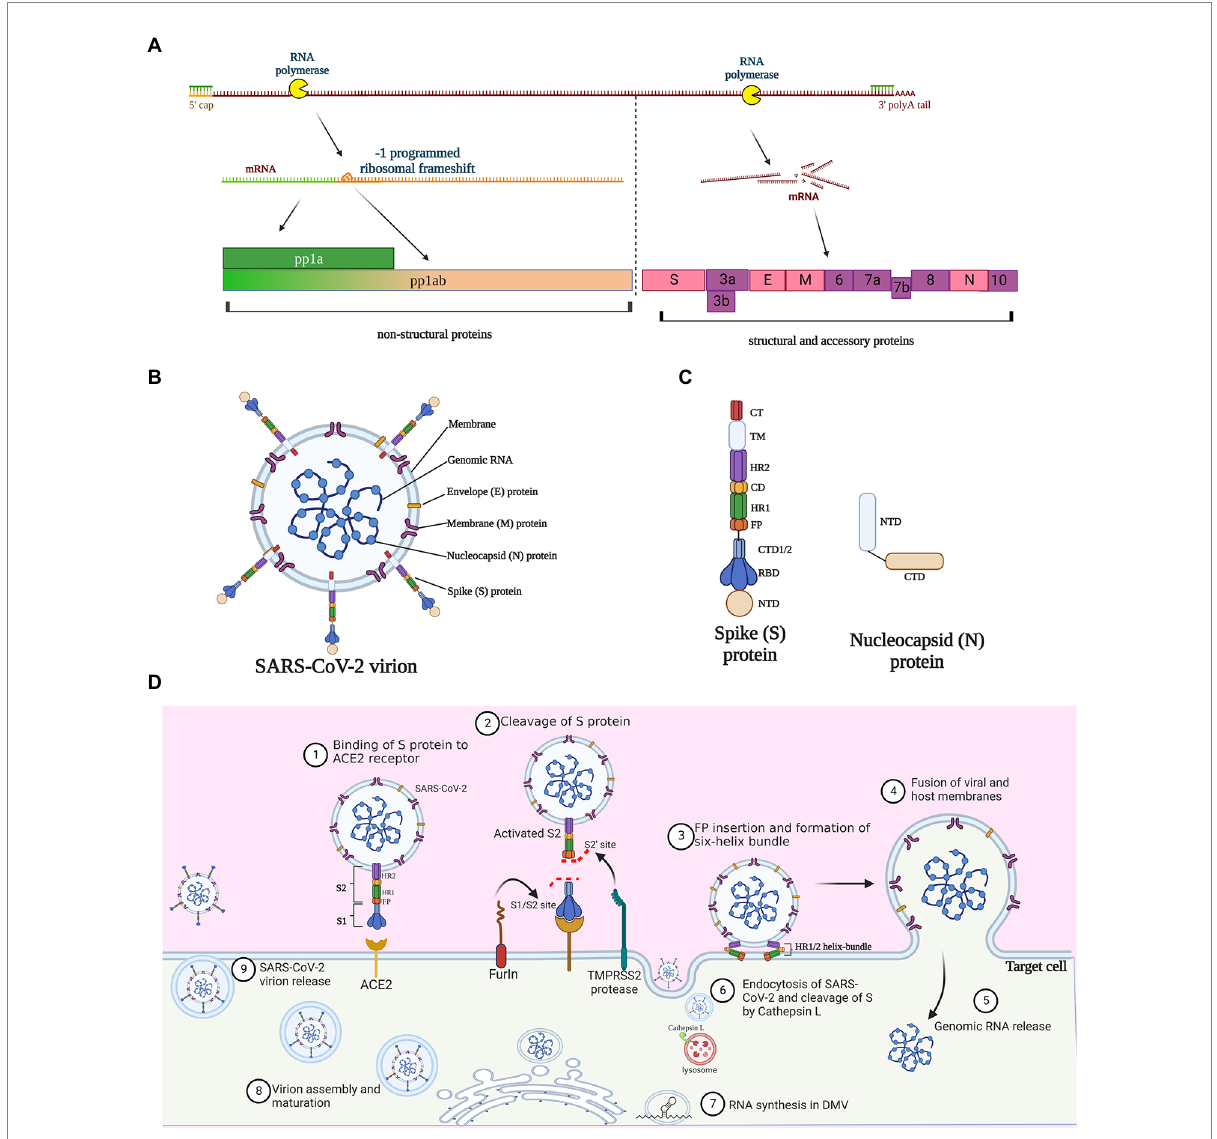
FIGURE 1 Molecular and structural bases of SARS-CoV-2 infection. (A) Proteins encoded by SARS-CoV-2 genome. Three quarters of the genome at the 5 ′ -terminus encode the replicase polyproteins pp1a and pp1ab, which can be cleaved to generate 16 nonstructural proteins; pp1ab is derived from minus 1 site programmed ribosomal frameshift at the stop codon during the synthesis of pp1a. The 3 ′ -terminus one quarter of the viral genome encode four structural proteins and accessory proteins. S, spike; E, envelope; M, membrane; and N, nucleocapsid. (B) Schematic diagram of SARS- CoV-2 virion structure. (C) Protein structure of spike protein and nucleocapsid protein. NTD, N-terminal domain; RBD, receptor-binding domain; CTD, C-terminal domain; FP, fusion peptide; HR, heptad repeat; CD, connector domain; TM, transmembrane domain; and CT, cytoplasmic tail. (D) The infection lifecycle of SARS-CoV-2. TMPRSS2, Type II transmembrane serine protease; ACE2, angiotensin-converting enzyme